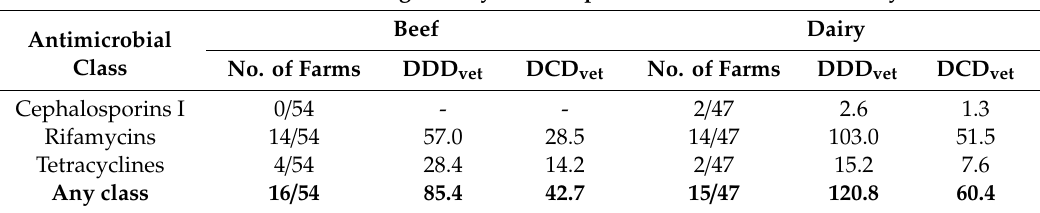
Table 3. Antimicrobial consumption (DDD vet / year × 10 − 3 − DCD vet / year × 10 − 3 ) via the intrauterine route per antimicrobial class and breeding category (for each administration route classes are listed only if they were part of at least one treatment performed on either beef or dairy